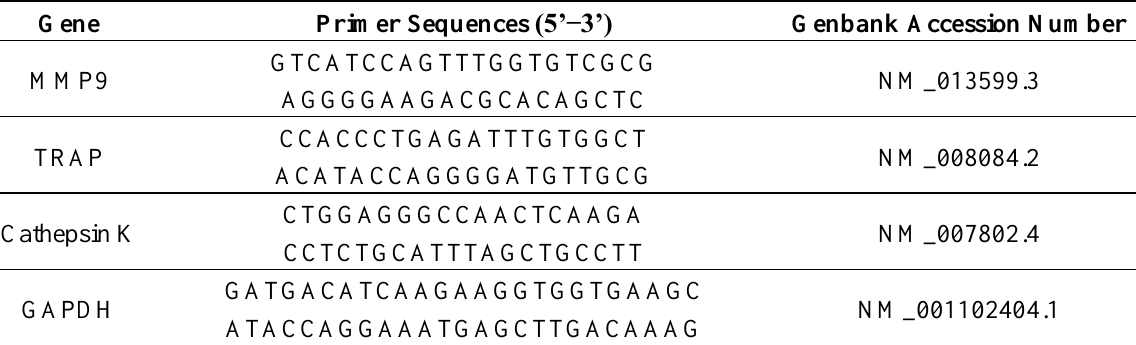
Table 1. Primers used in this